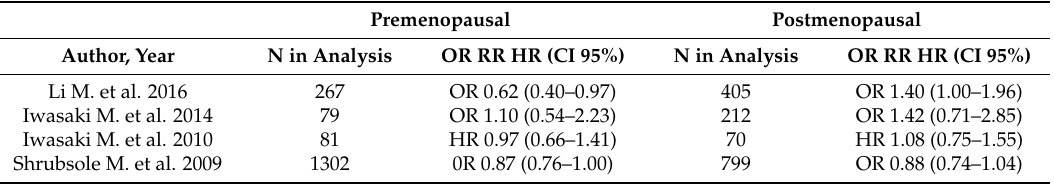
Table 3. Data extracted from primary studies focusing on menopausal status.